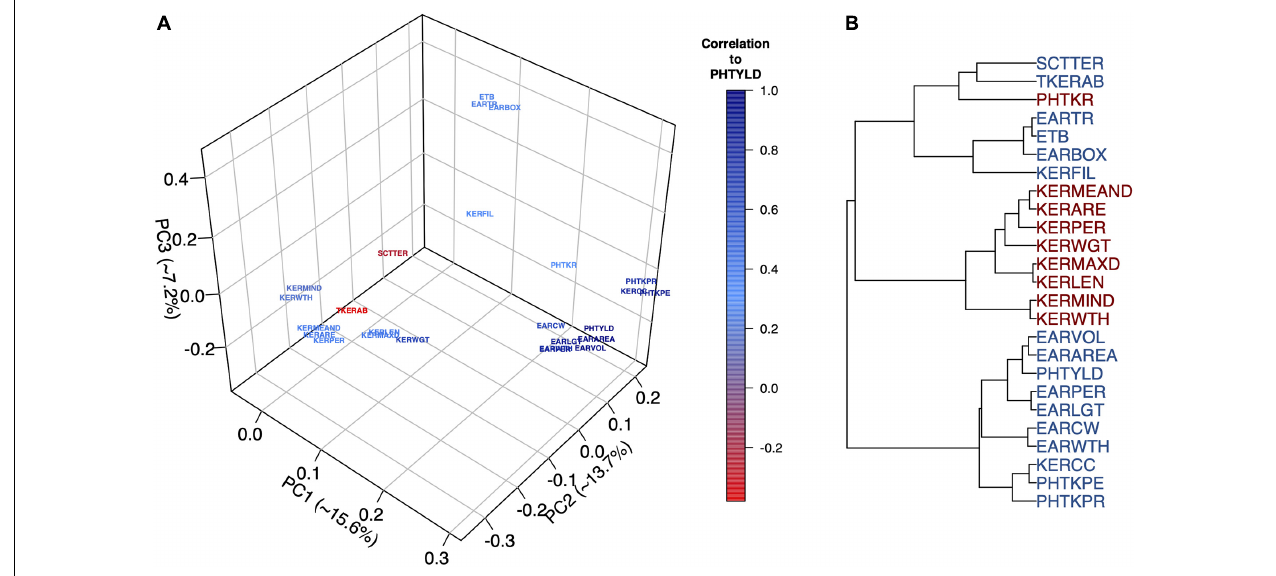
FIGURE 2 | Principal Component Analysis (PCA) to visualize the ear photometry (EP) traits and their correlation to photometry-estimated yield (PHTYLD) (A) . Dendrogram displaying the hierarchical clustering of EP traits using Ward’s Minimum Variance. The Ball-Hall index was used to determine the correct number of groups (5) among the EP traits (B) .